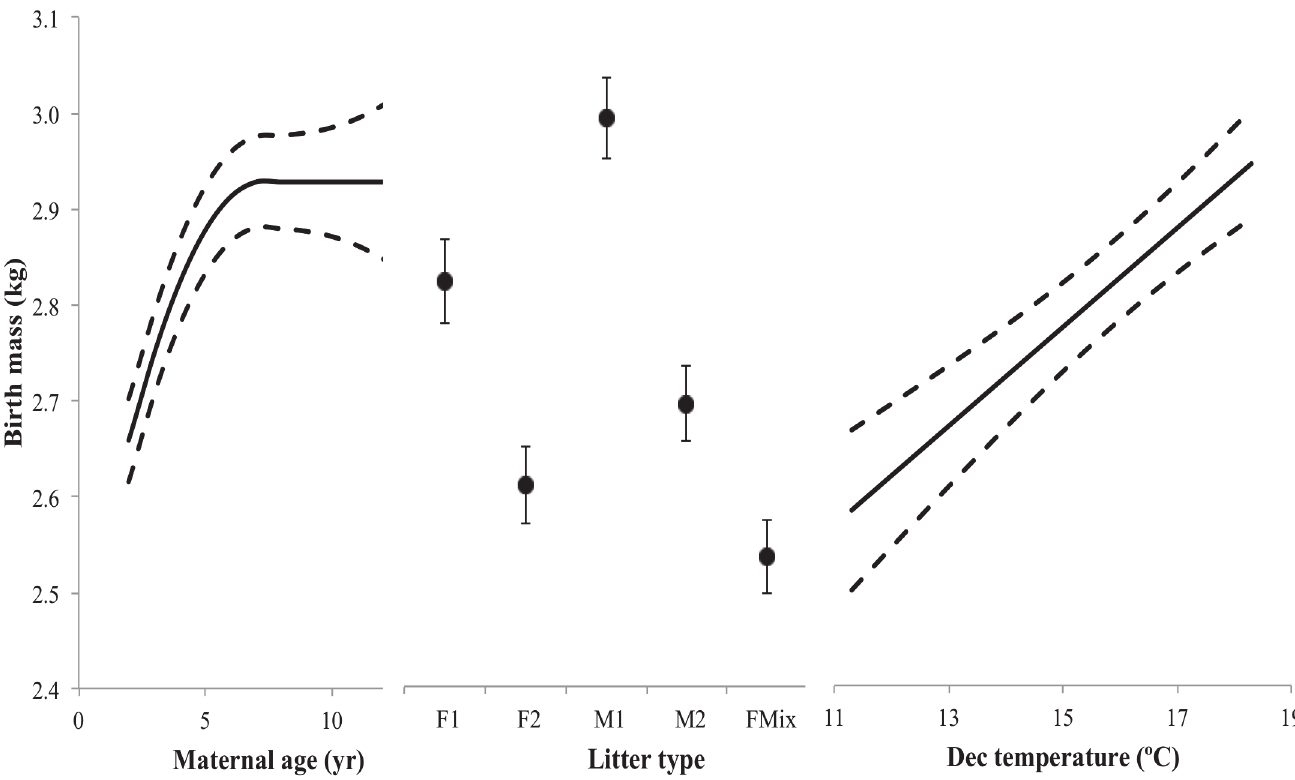
Fig 4. Predicted values from a linear mixed effect model estimating the birth mass (kg) of captive white-tailed deer at Kerr Wildlife Management Area, Kerr County, Texas, USA from 1977 – 2012. Predicted birth mass was estimated across the range of each variable deemed important while controlling for all other variables (variable constants included: Maternal age = 4, Litter type = female singleton, Study program = study program 1, and December temperature = 16.0°C). The solid lines represent the predicted estimate for birth mass and the dashed lines are the standard error envelopes for the estimates. Random effects were treated as categorical variables and included a unique identifier for each mother and the year of birth for each fawn.